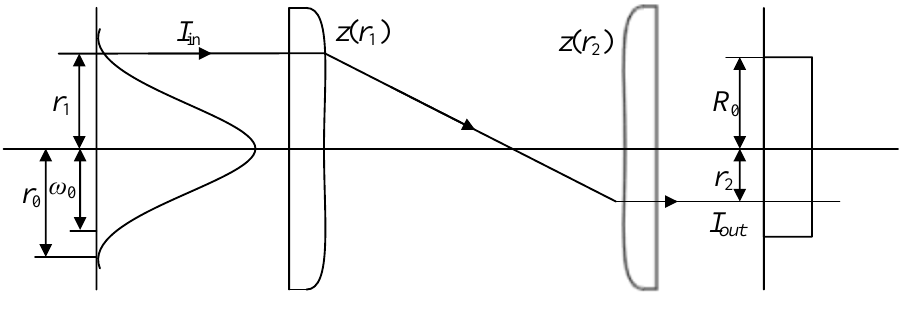
Figure 2. Beam - shaping model.